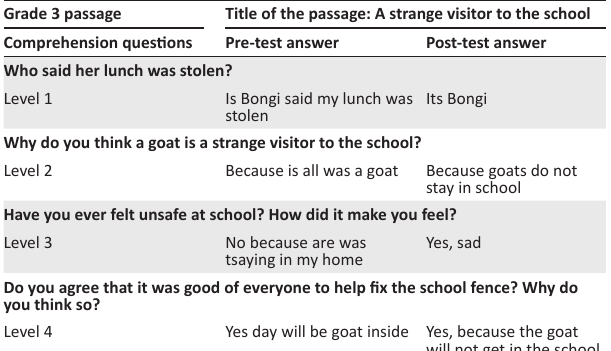
TABLE 1: L1’s written pre-test and post-test responses.